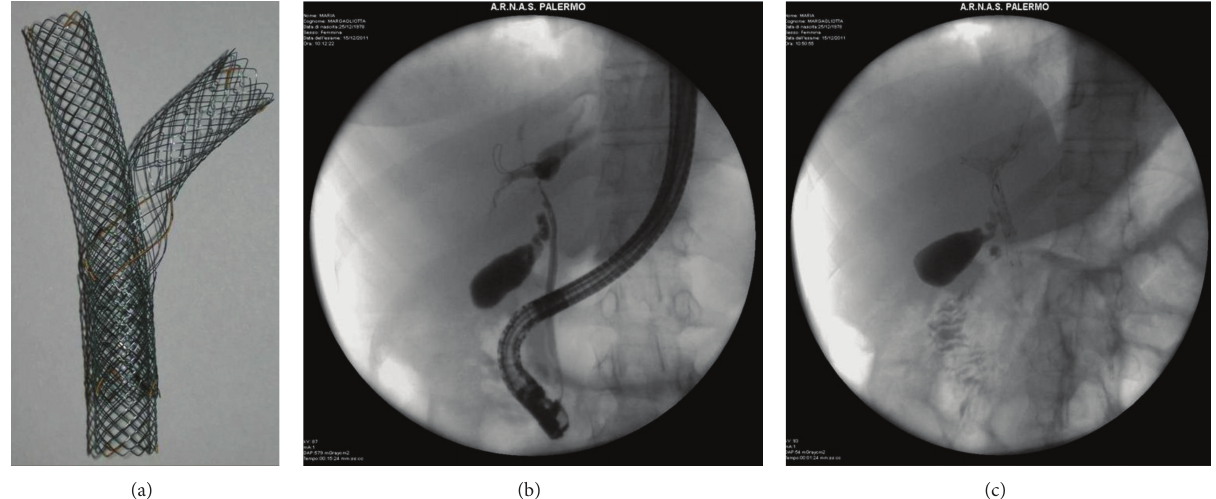
Figure 1: (a) Niti-S stent assembled (Y-shaped configuration). (b-c) Images from a patient with hilar cholangiocarcinoma before (b) and after (c) stent